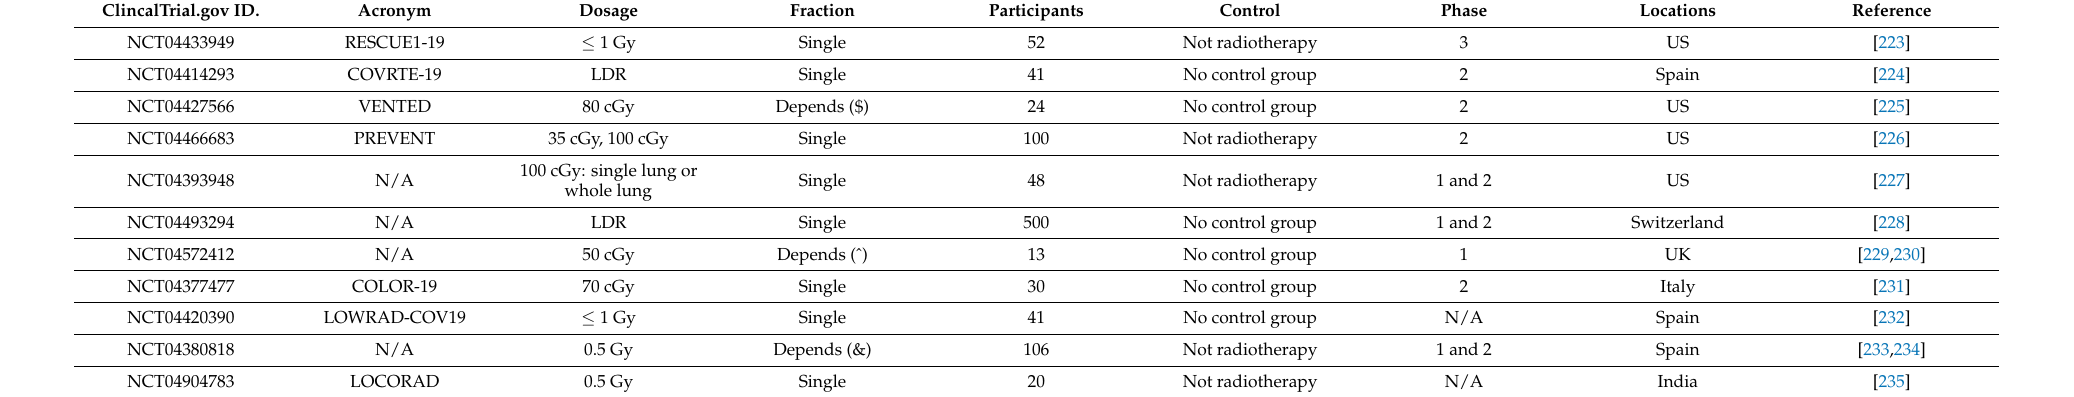
Table 3. Summary of Current Ongoing Clinical Trials Using Radiation Therapy for